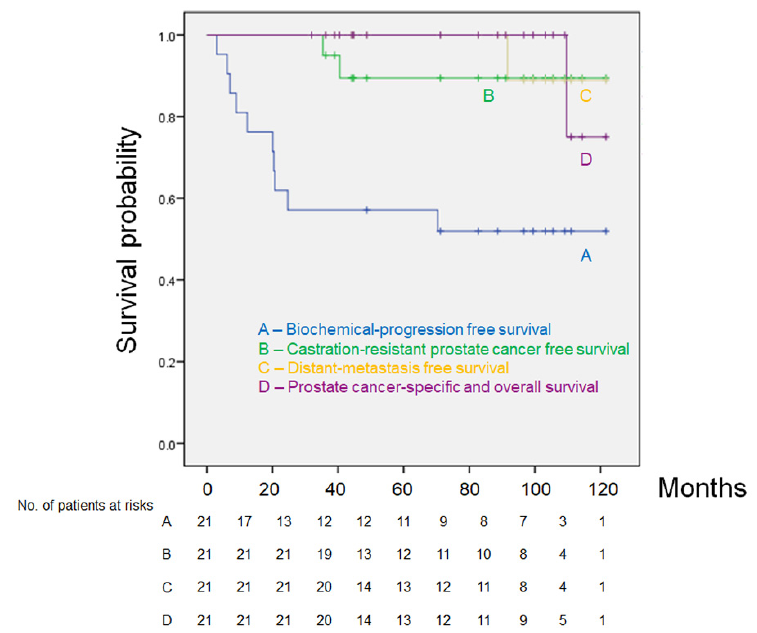
Figure 1. Kaplan–Meier estimates of biochemical progression-free survival ( A ), castration-resistant prostate cancer-free survival ( B ), distant metastasis-free survival ( C ), prostate cancer-specific survival, and overall survival ( D ).